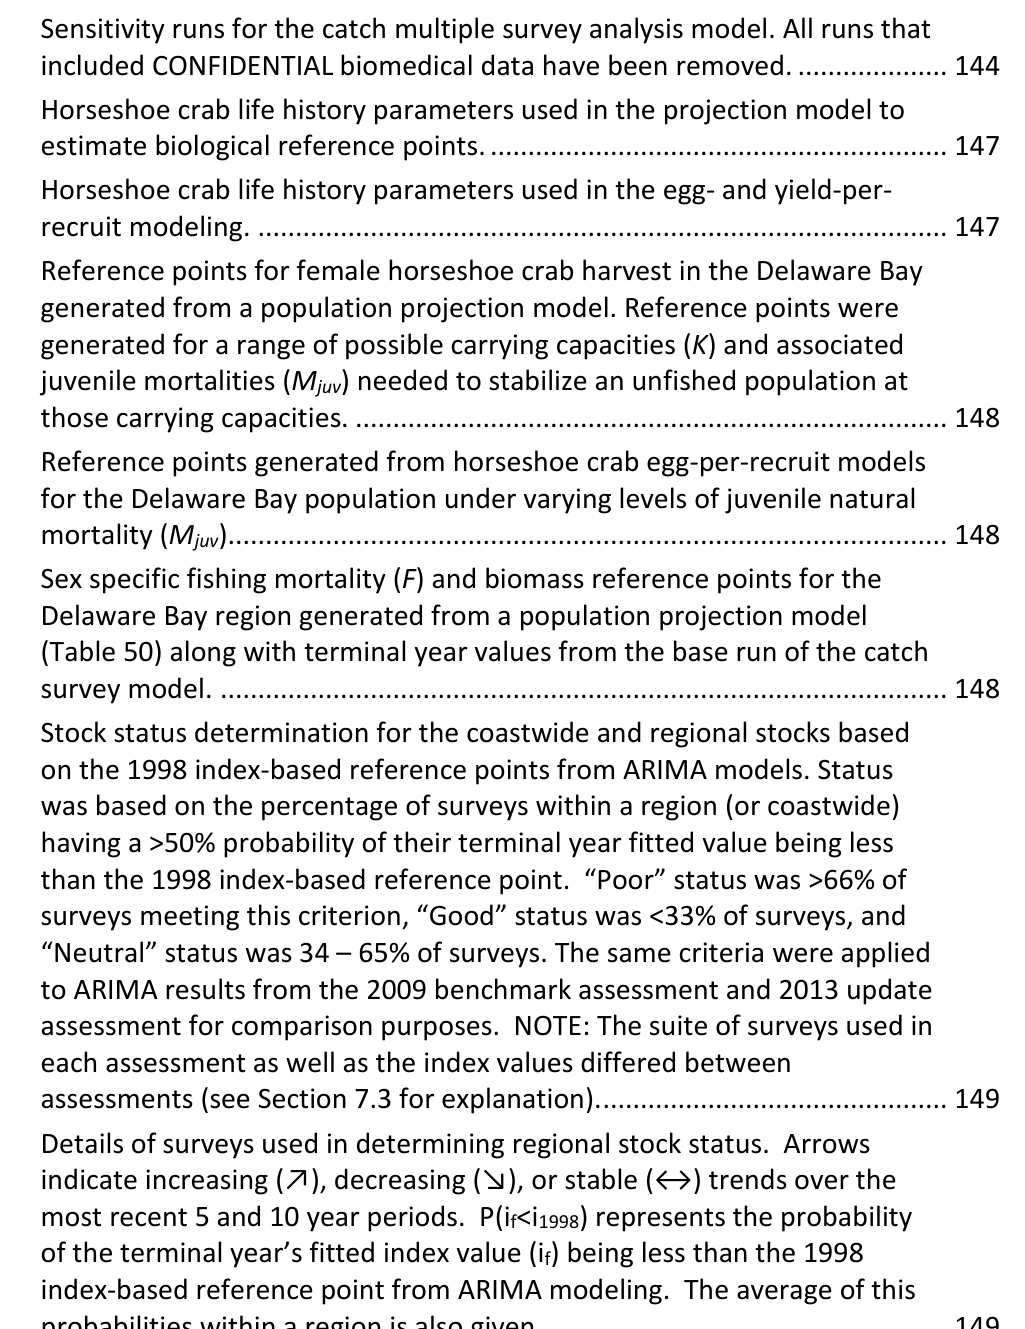
Sensitivity runs for the catch multiple survey analysis model. All runs that Horseshoe crab life history parameters used in the projection model to Horseshoe crab life history parameters used in the egg- and yield-per- Reference points for female horseshoe crab harvest in the Delaware Bay generated from a population projection model. Reference points were generated for a range of possible carrying capacities ( K ) and associated juvenile mortalities ( M juv ) needed to stabilize an unfished population at Reference points generated from horseshoe crab egg-per-recruit models for the Delaware Bay population under varying levels of juvenile natural Sex specific fishing mortality ( F ) and biomass reference points for the Delaware Bay region generated from a population projection model (Table 50) along with terminal year values from the base run of the catch Stock status determination for the coastwide and regional stocks based on the 1998 index-based reference points from ARIMA models. Status was based on the percentage of surveys within a region (or coastwide) having a >50% probability of their terminal year fitted value being less than the 1998 index-based reference point. “Poor” status was >66% of surveys meeting this criterion, “Good” status was <33% of surveys, and “Neutral” status was 34 – 65% of surveys. The same criteria were applied to ARIMA results from the 2009 benchmark assessment and 2013 update assessment for comparison purposes. NOTE: The suite of surveys used in each assessment as well as the index values differed between Details of surveys used in determining regional stock status. Arrows indicate increasing (↗), decreasing (↘), or stable (↔) trends over the most recent 5 and 10 year periods. P(i f <i 1998 ) represents the probability of the terminal year’s fitted index value (i f ) being less than the 1998 index-based reference point from ARIMA modeling. The average of this Comparison of the current stock assessment and the adaptive resource management (ARM) model for horseshoe crabs in the Delaware